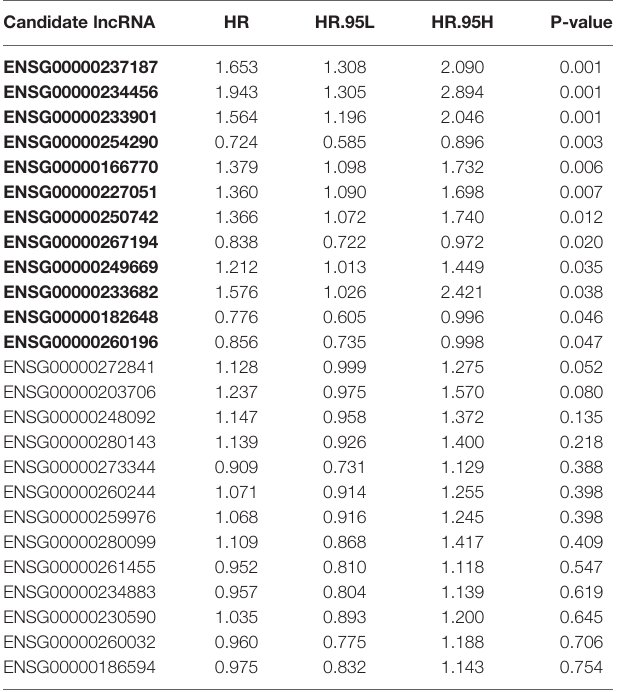
TABLE 2 | The twelve m6A-related prognostic